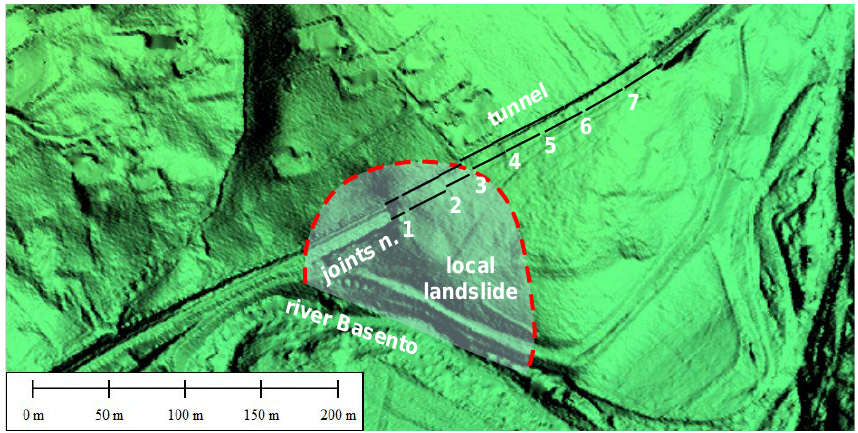
Figure 5. Digital terrain model of the major landslide and of the local landslide. The localization of sectors and joints is indicated in correspondence of the tunnel.